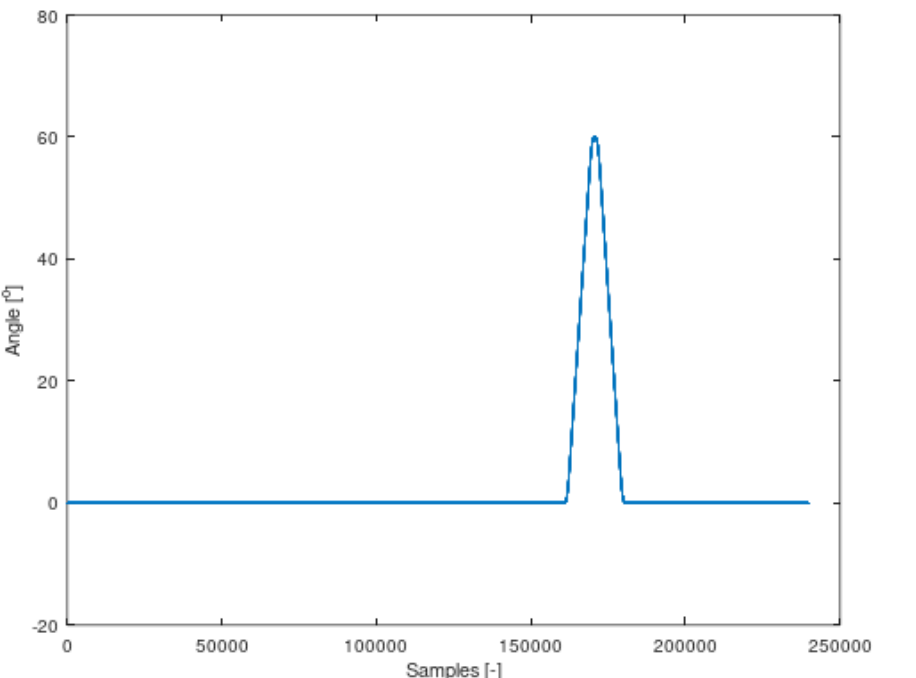
Figure 7. The angle set on the robot axis to which the coordinate system is assigned z 4 x 4 in Figure 3. Data from FANUC robot encoders collected using the apparatus.